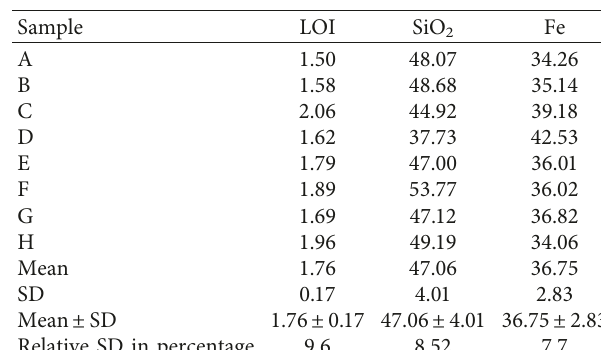
Table 4: A comparative study of LOI, SiO 2 , and Fe estimation of hematite ore by titration method. The mean value in the table represents the mean of each channel samples assigned from A to H.